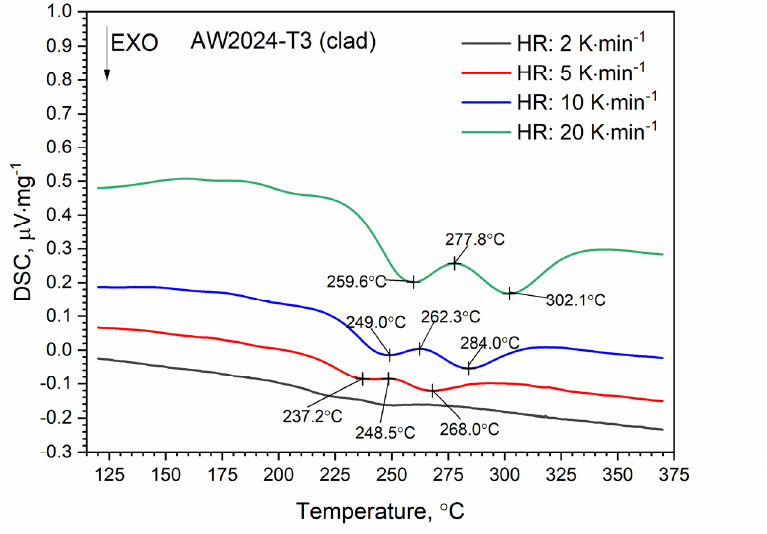
Figure 10. DSC thermograms of clad AW-2024-T3 at various HRs.